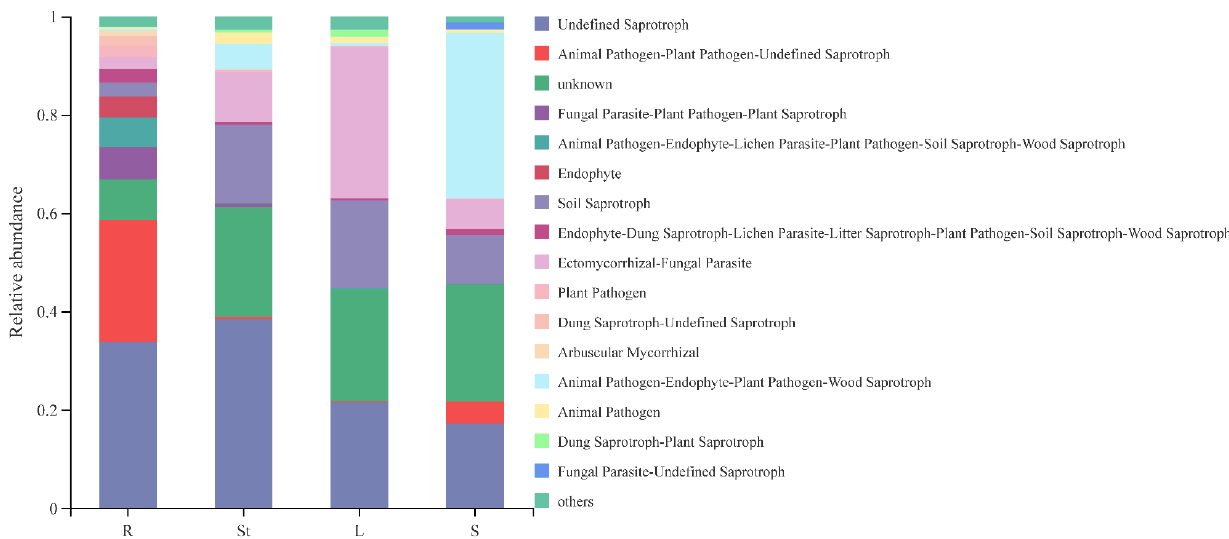
Figure 5. Ecological function analysis of endophytic fungi in various organs of S. alopecuroides